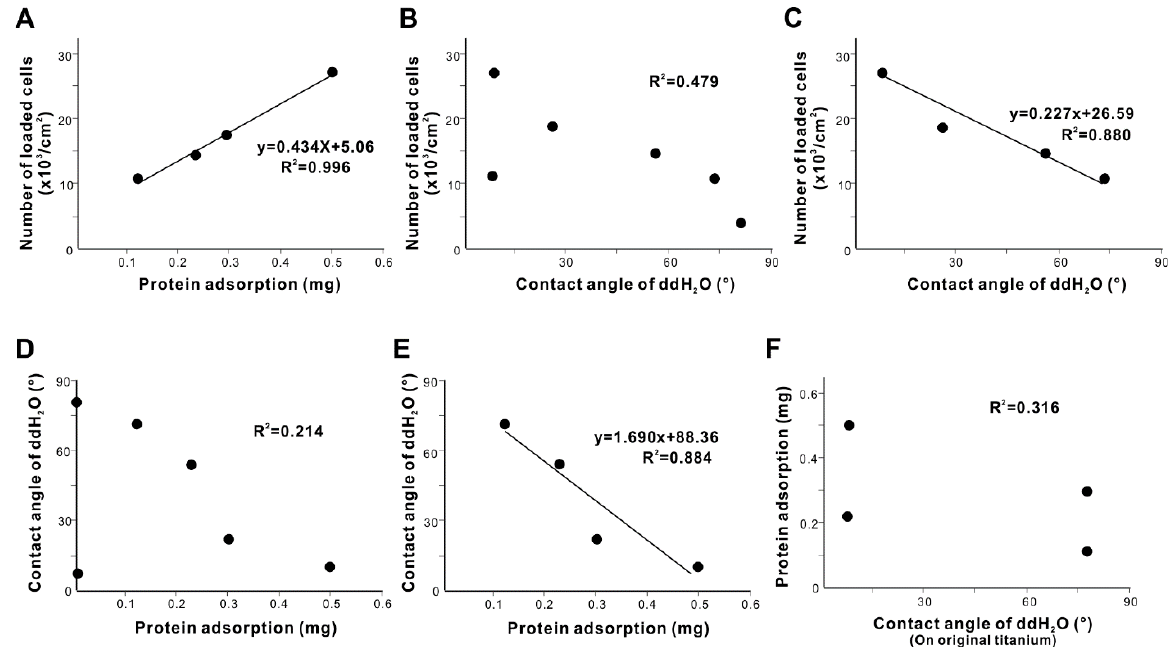
Figure 6. Determinants for cell-loading capability of titanium surfaces. Line graphs show the relationship between the amount of protein adsorption and the number of loaded cells ( A ) and between the contact angle and the number of loaded cells ( B , C ). All titanium surfaces were counted in panel ( B ), and only titanium surfaces with protein pre-adsorption were counted in panel ( C ). ( D , E ) The determinants for the contact angle. Line graphs show the relationship between the amount of protein adsorption and the ddH 2 O contact angle ( D , E ). All titanium surfaces were counted in panel ( D ), and only titanium surfaces with protein pre-adsorption were counted in panel ( E ). Panel F plots the ddH 2 O contact angle on the original titanium surfaces and the amount of protein adsorption.